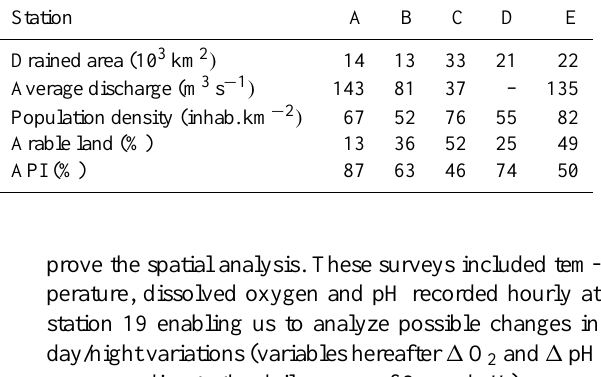
Table 2. Major tributaries station characteristics. Station